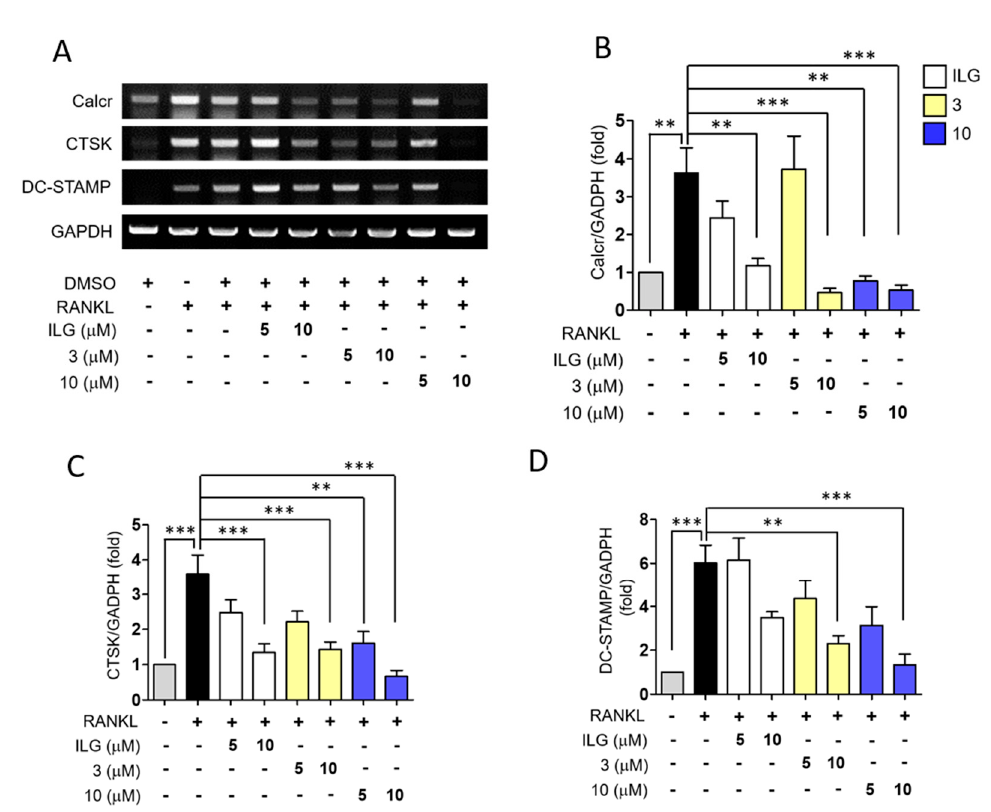
Figure 4. Inhibition effect of osteoclast specific genes by ILG and ILG derivatives. ILG and ILG derivatives down-regulated gene expression of osteoclast specific genes such as ( A ) Calcr, CTSK, and DC-STAMP at mRNA levels of RAW264.7 cells. ( B – D ) The RT-PCR results were normalized to GAPDH about Calcr, CTSK, and DC-STAMP. Data are presented as the mean ± SEM of more three determinations. * p < 0.05, ** p < 0.01, *** p < 0.001. ( n ≥ 3).